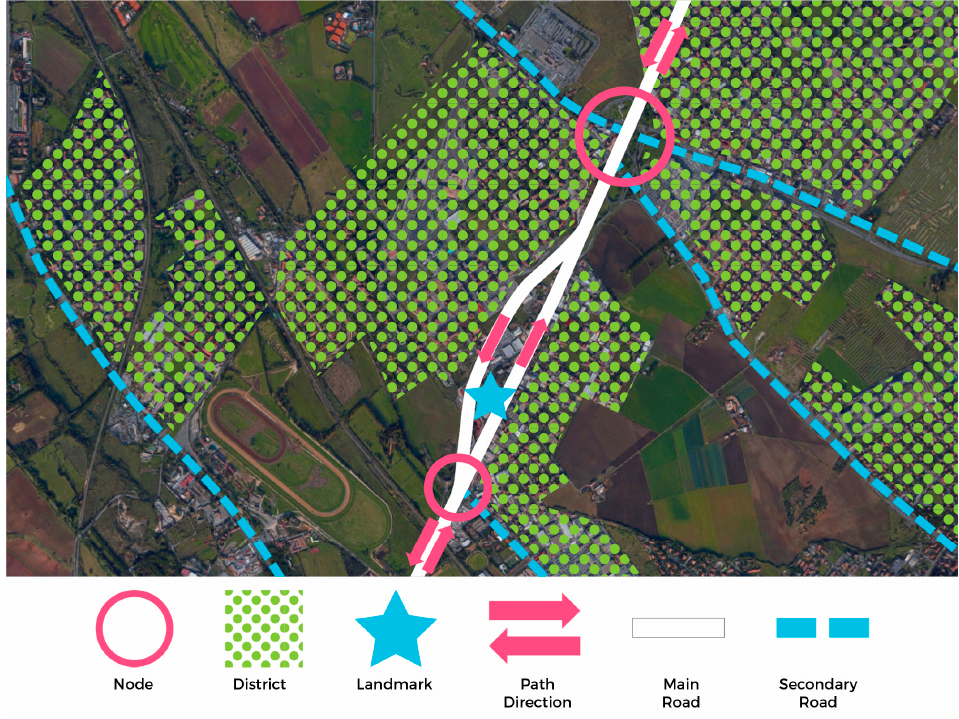
Figure 2. Analysis of the site according to Lynch studies (image by Rosario Di